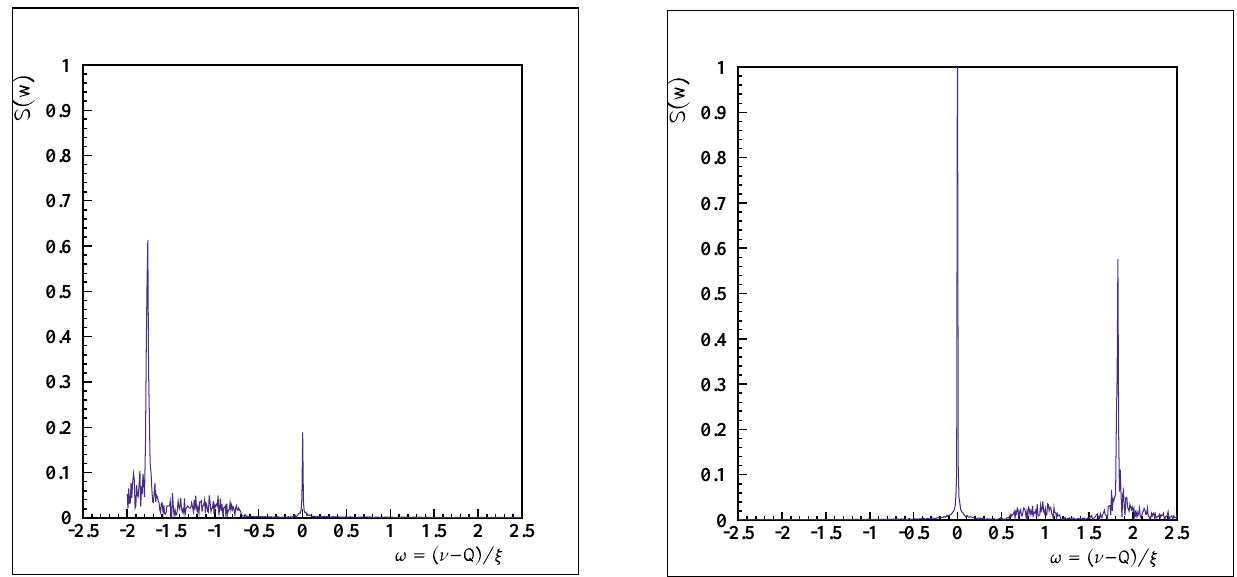
FIG. 10. (Color) Spectrum of the vertical (left) and horizontal (right) centroid motion for long-range collision with horizontal sepa- ration L x (cid:1) 6.0 (in units of s x ) and no head-on collision ( 2 15 turns, N (cid:1) 10 4 macroparticles). The tune shifts due to long-range collisions have opposite signs in the two transverse